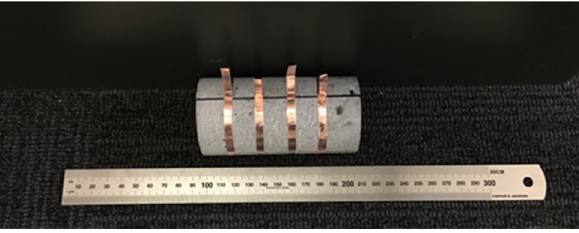
Figure 3: Samples with copper tapes every 2 cm.